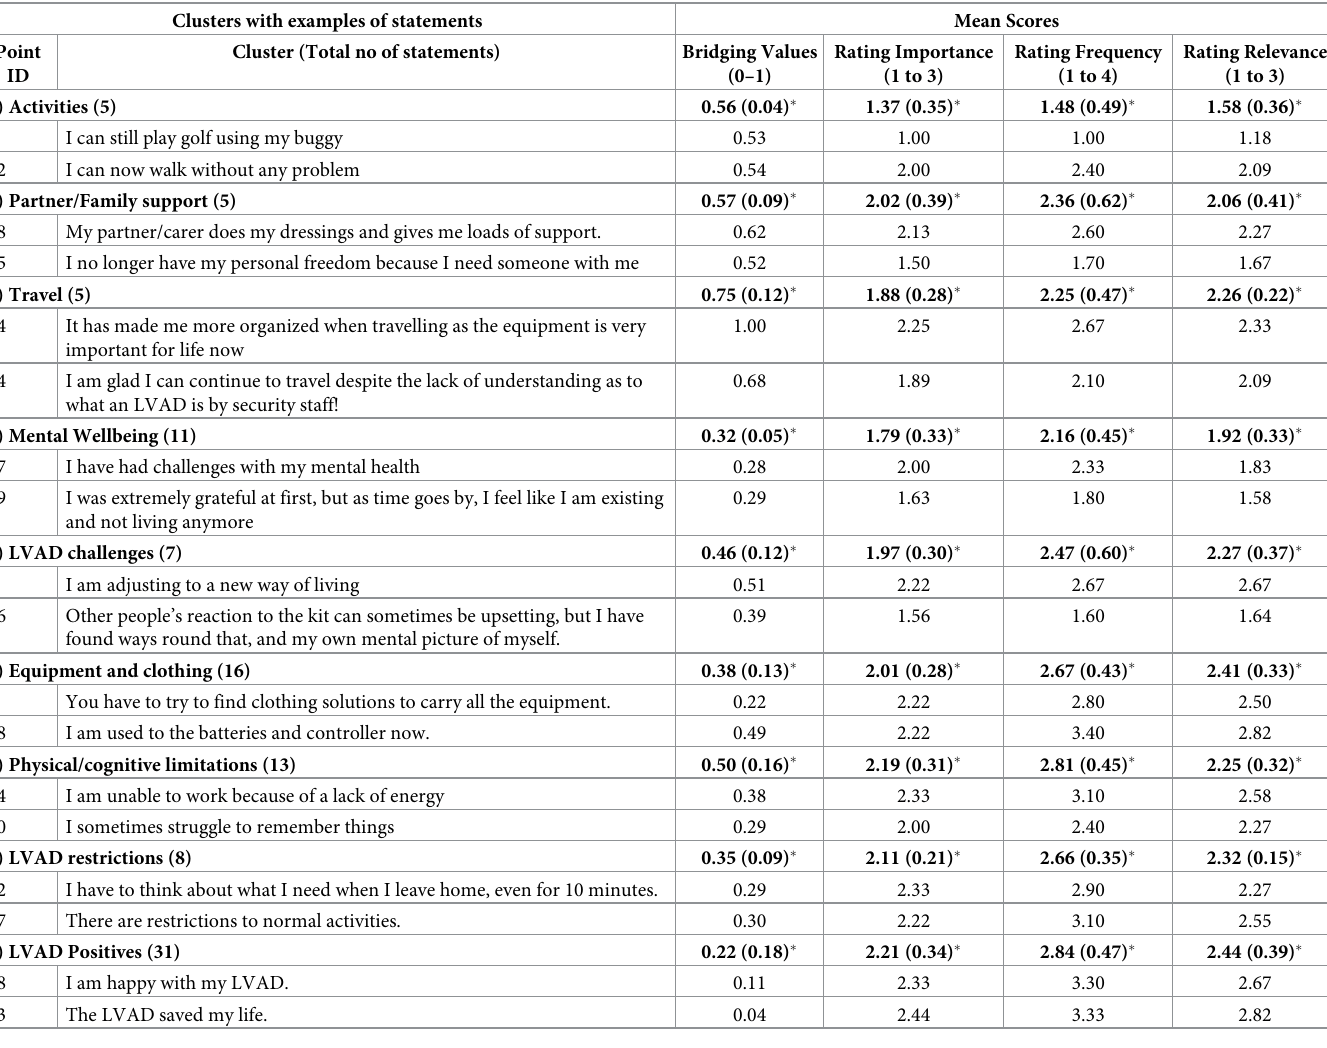
Table 1. Cluster descriptions and examples of included